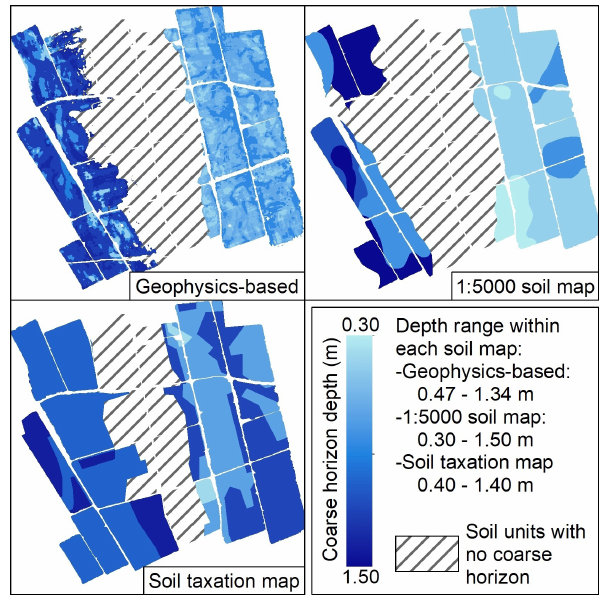
Figure 5. Depth of the coarse horizon 2C in the three soil